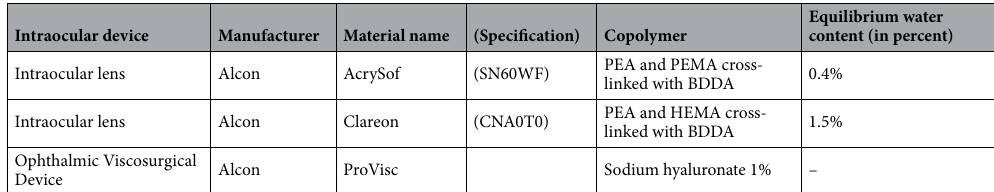
Table 1. Specifications of intraocular devices used in this study. PEA phenylethyl acrylate, PEMA phenylethyl methacrylate, HEMA hydroxyethyl methacrylate, BDDA butanediol